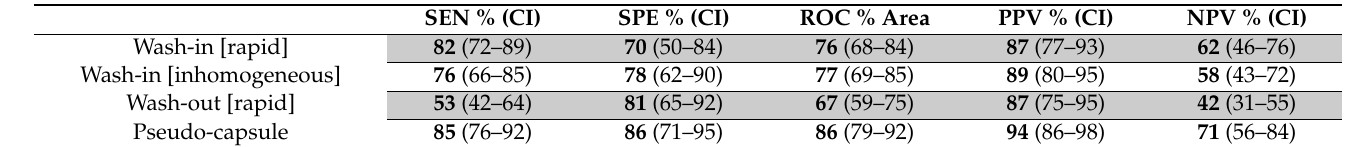
Table 4. Diagnostic performance of qualitative evaluation performed by CEUS (SEN: Sensitivity; SPE: Specificity; ROC: Receiver Operating Characteristics; PPV: Positive Predictive Value; NPV: Negative Predictive